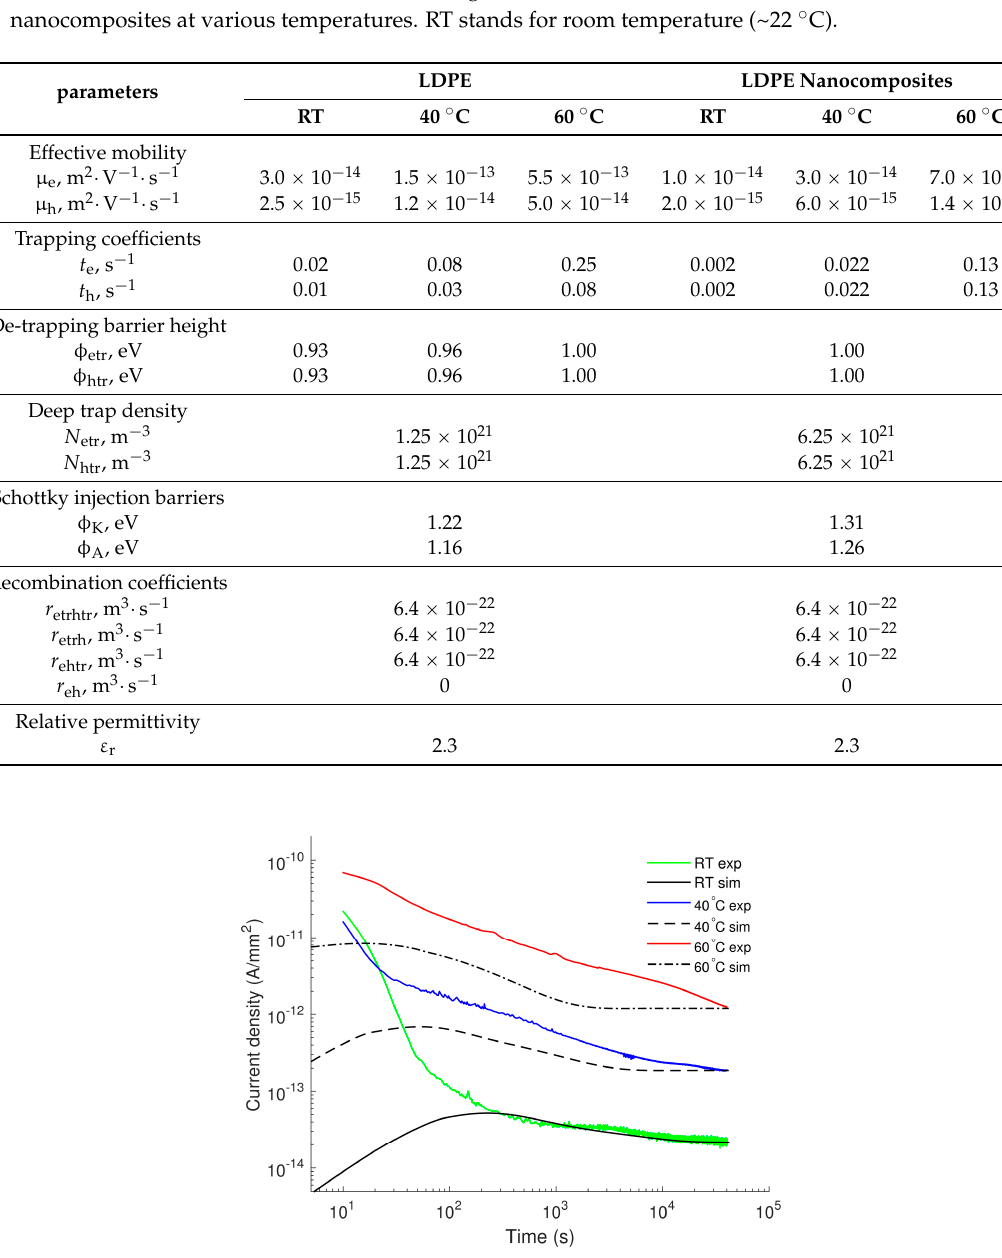
Figure 1. Simulated (referred as “sim” in the legend) and experimental (exp) current densities on LDPE at various temperatures.